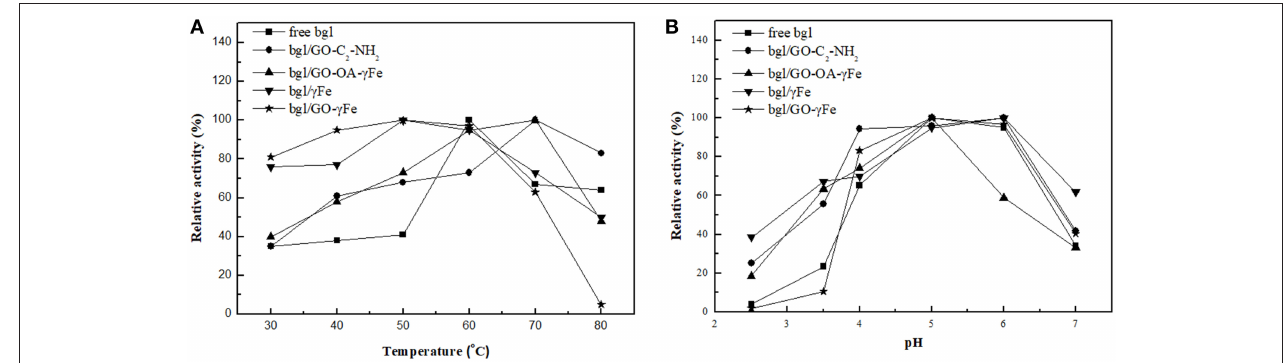
FIGURE 7 | Effect of (A) temperature and (B) pH on the relative activity of free and immobilized bgl. One hundred percentage indicates the highest activity exhibited each time either by free enzyme or the nanobiocatalyst tested.